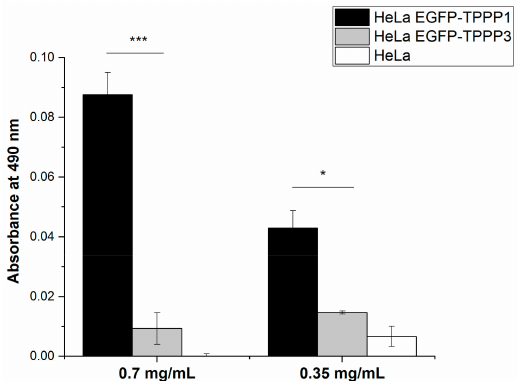
Figure 8. Interaction of SYN with TPPP3 as compared with that of TPPP1. In an ELISA experiment, extracts of HeLa cells transfected with pEGFP-TPPP3 (grey) and pEGFP-TPPP1 (black) were added to the immobilized SYN. HeLa extract (white) was used as control. The bound proteins were quantified by EGFP antibodies. Statistical comparisons were performed with two-sided, unpaired Student’s t -test, as compared as the lines indicate (* p < 0.05 and *** p < 0.001).